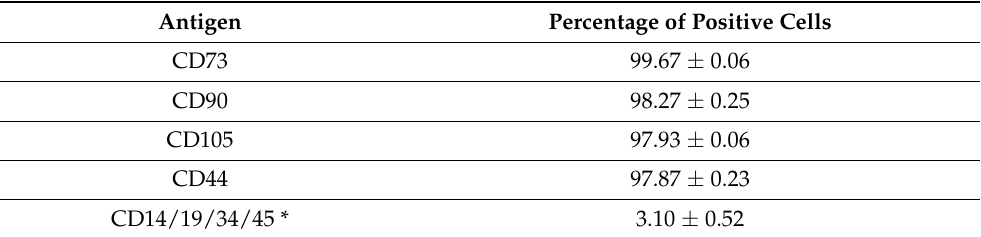
Table 1. Flow cytometric analysis for cluster of differentiation (CD) marker expression of ah -BM- MSCs at passages 3–4. * Hematopoietic